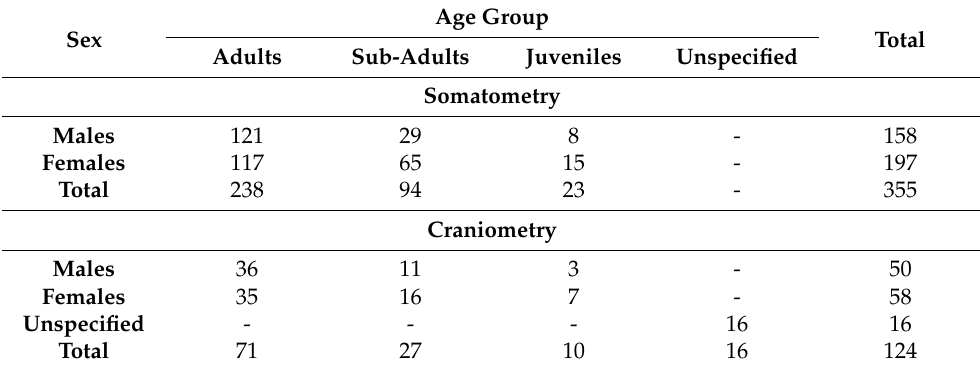
Table 1. Overview of Pannonian root vole specimens morphometrically